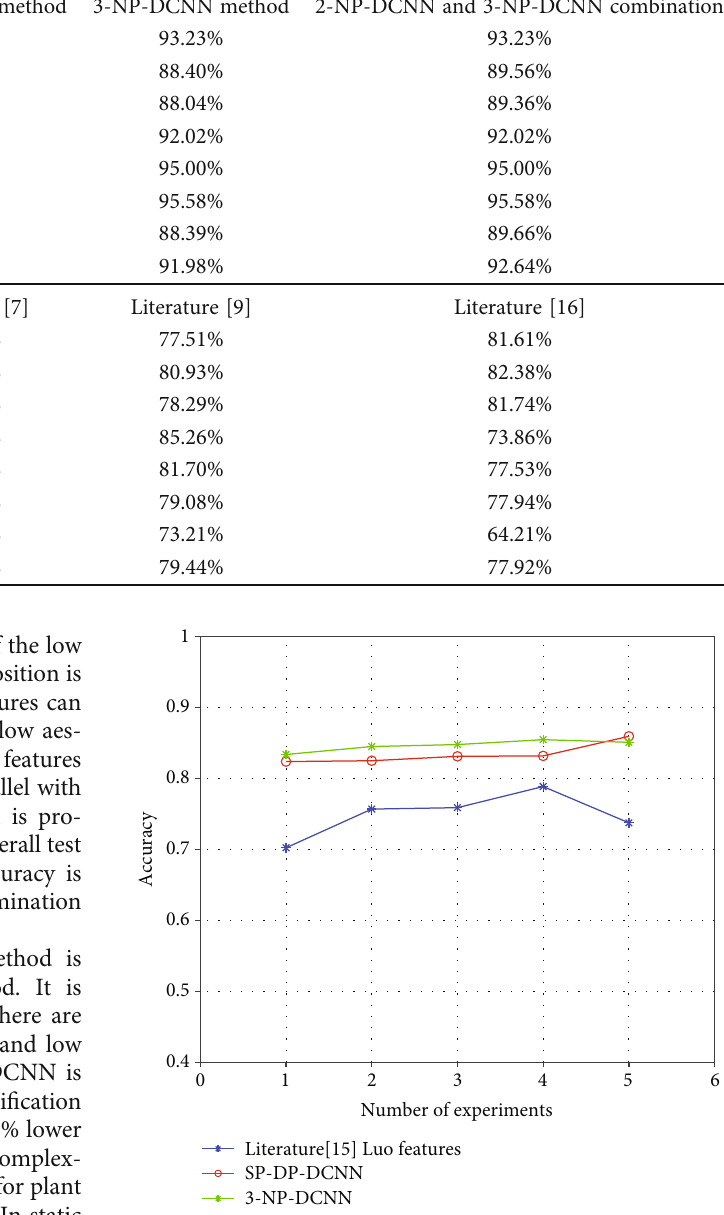
Figure 6: Comparison of test accuracy between the NP-DP-DCNN method and other methods in the CUHK